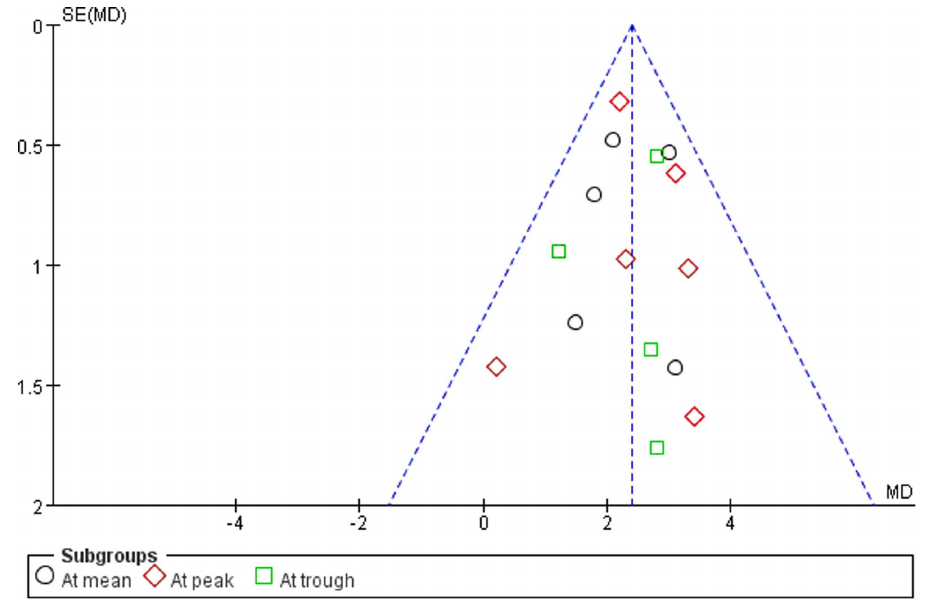
Figure 3. Funnel plots of RCTs comparing lantanoprost with timolol in IOP reduction. doi:10.1371/journal.pone.0096852.g003 PLOS ONE |